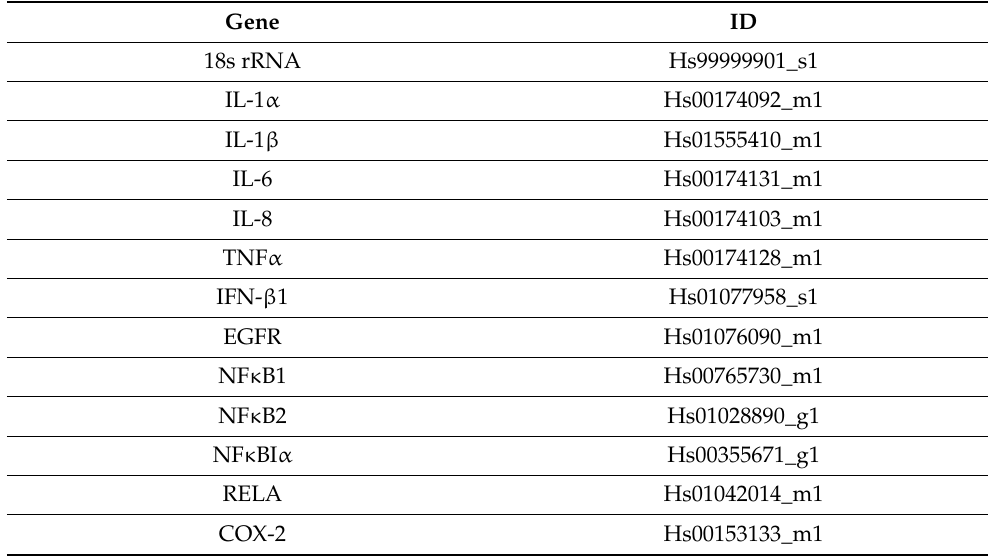
Table 1. List of genes used in real-time PCR using inventoried TaqMan Gene Expression